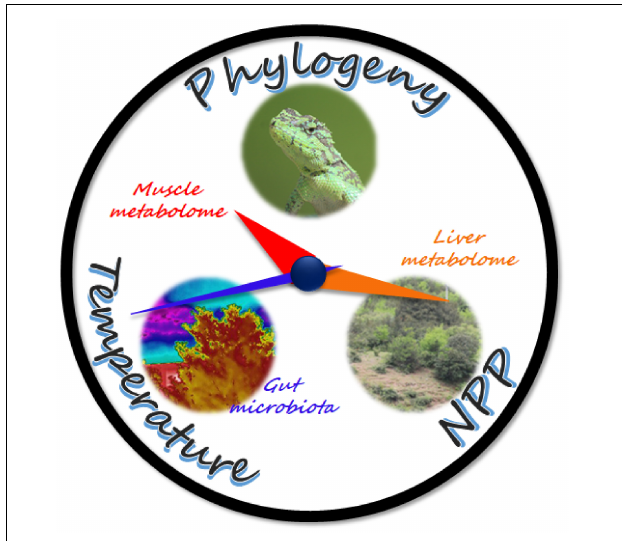
FIGURE 7 | Schematic diagram of the results. The hour, minute, and second hands of the clock symbolize the muscle, liver, and gut microbiomes of the mountain dragons, respectively, and they are pointing to their respective major determinators. The movement speed of the clock hands symbolizes the variability, whether genetic or plastic, of organ metabolome and gut microbiome to the climatic factors. The faster they move, the more variable they